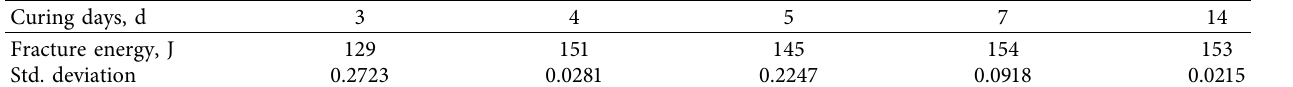
Figure 11: Fracture energy of PA and SFP specimen with different curing days. Table 6: Fracture energy of grouting materials with different curing days.